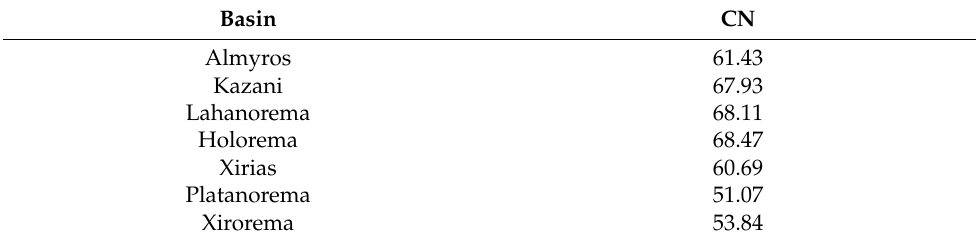
Table 5. Curve Number of the Almyros basin and its sub-basins.